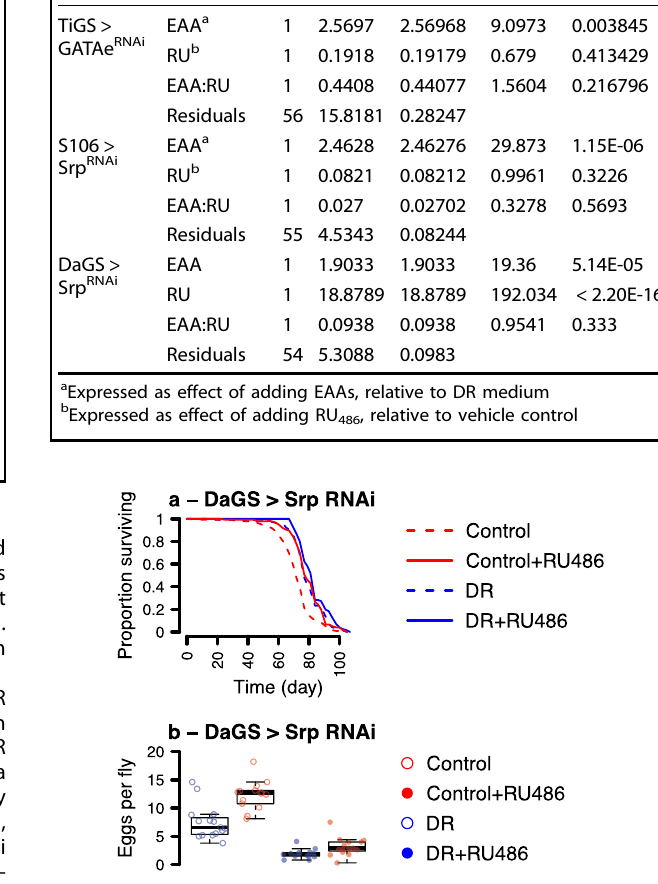
Fig. 4 Systemic srp knockdown recapitulates bene fi ts of DR at enhanced cost. Survival curves of fl ies fed EAA-replete or DR media, with/without expression of RNAi against srp under control of daughterless GeneSwitch ( a ), with complementary egg laying indices ( b ). Control medium was EAA-replete. Survival curves show proportion surviving over time. Box plots show medians, fi rst